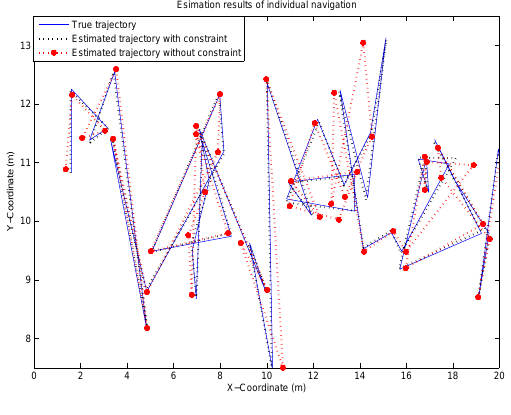
Figure 13. State estimation of individual